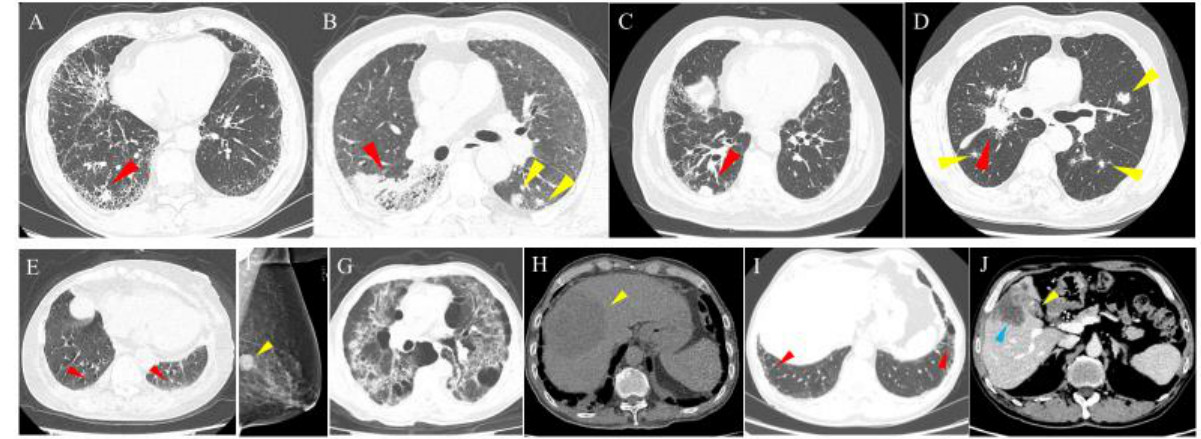
Figure 4. Cases of patients with ILD and malignancies. ( A ) A 65-year-old male with IPF and lung cancer. HRCT shows an irregular solid nodule in the right lower lobe (red arrowhead). ( B ) A 62-year-old male with NSIP and lung cancer. HRCT shows an irregular mass and ground glass opacity (red arrowhead) in the right lower lobe and multiple irregular nodules in the left lower lobe (yellow arrowhead). ( C ) A 74-year-old male with RA-associated ILD and lung cancer. HRCT shows a subpleural solid nodule in the right lower lung (red arrowhead). ( D ) A 63-year-old male with OP and lung cancer. HRCT shows an irregular mass in the right hilum (red arrowhead) and multiple metastases in bilateral lungs (yellow arrowhead). A 90-year-old female patient with ILD and breast cancer. HRCT shows ground glass opacity and a reticular pattern (red arrowhead) in the bilateral lower lobes ( E ) and a dense nodule (yellow arrowhead) in the left breast on mammography ( F ). A 57-year-old male patient with ILD and hepatocellular carcinoma. HRCT shows multiple patches of ground glass opacity, a reticular pattern, cystic spaces, and traction bronchiectasis in the bilateral lungs ( G ), and abdominal non-contrasted CT shows hepatocellular carcinoma (yellow arrowhead) as an irregular lower density mass in the right lobe of the liver ( H ). A 65-year-old male patient with ILD combined with gallbladder cancer. HRCT shows subpleural ground glass opacity and a reticular pattern (red arrowhead) in the bilateral lower lungs ( I ). Abdominal contrasted CT shows the enhanced lesion in the gallbladder (yellow arrowhead) and liver invasion (blue arrowhead) ( J ). HRCT, high-resolution computed tomography; ILD, interstitial lung disease; IPF, idiopathic pulmonary fibrosis; NSIP, nonspecific interstitial pneumonia; RA, rheumatoid arthritis; OP, organizing pneumonia. Table 4. Malignancies in IIP, CTD-ILD, and other ILDs.